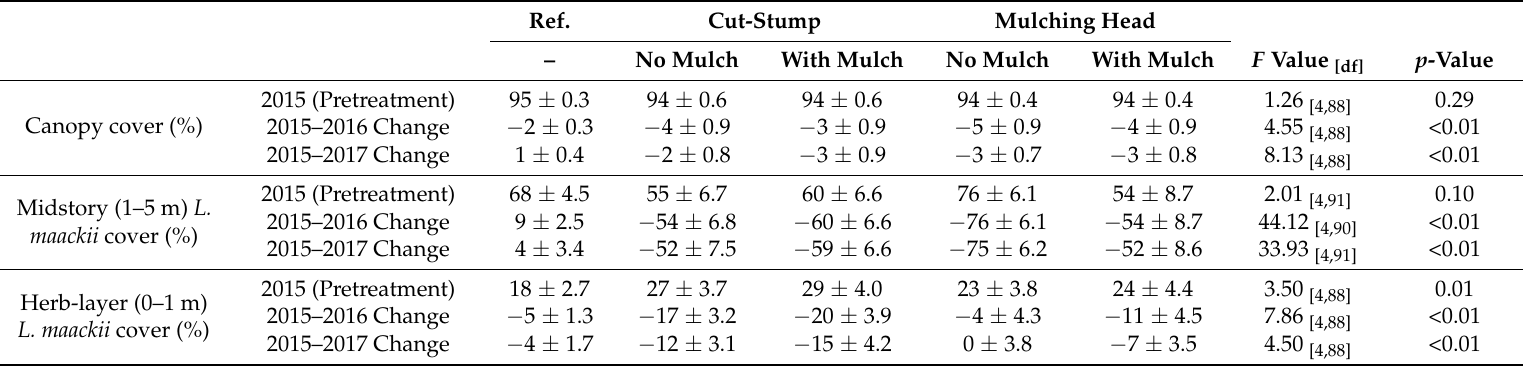
Table 3. Percent cover (mean ± standard error) of understory honeysuckle, midstory honeysuckle, and overall canopy in response to cut-stump and mulching head honeysuckle control. Understory, midstory, and canopy cover were estimated in four 1-m 2 quadrats, one 4-m 2 quadrat, or four spherical densiometer readings, respectively, at each plot. F and p -values are from linear mixed models testing whether each variable varied between treatments. Satterthwaite’s approximation for degrees of freedom was used to estimate p -values and p -values are presented to the nearest integer. Data were collected in late July to early August each year at four mature secondary hardwood forest sites near West Lafayette, IN,